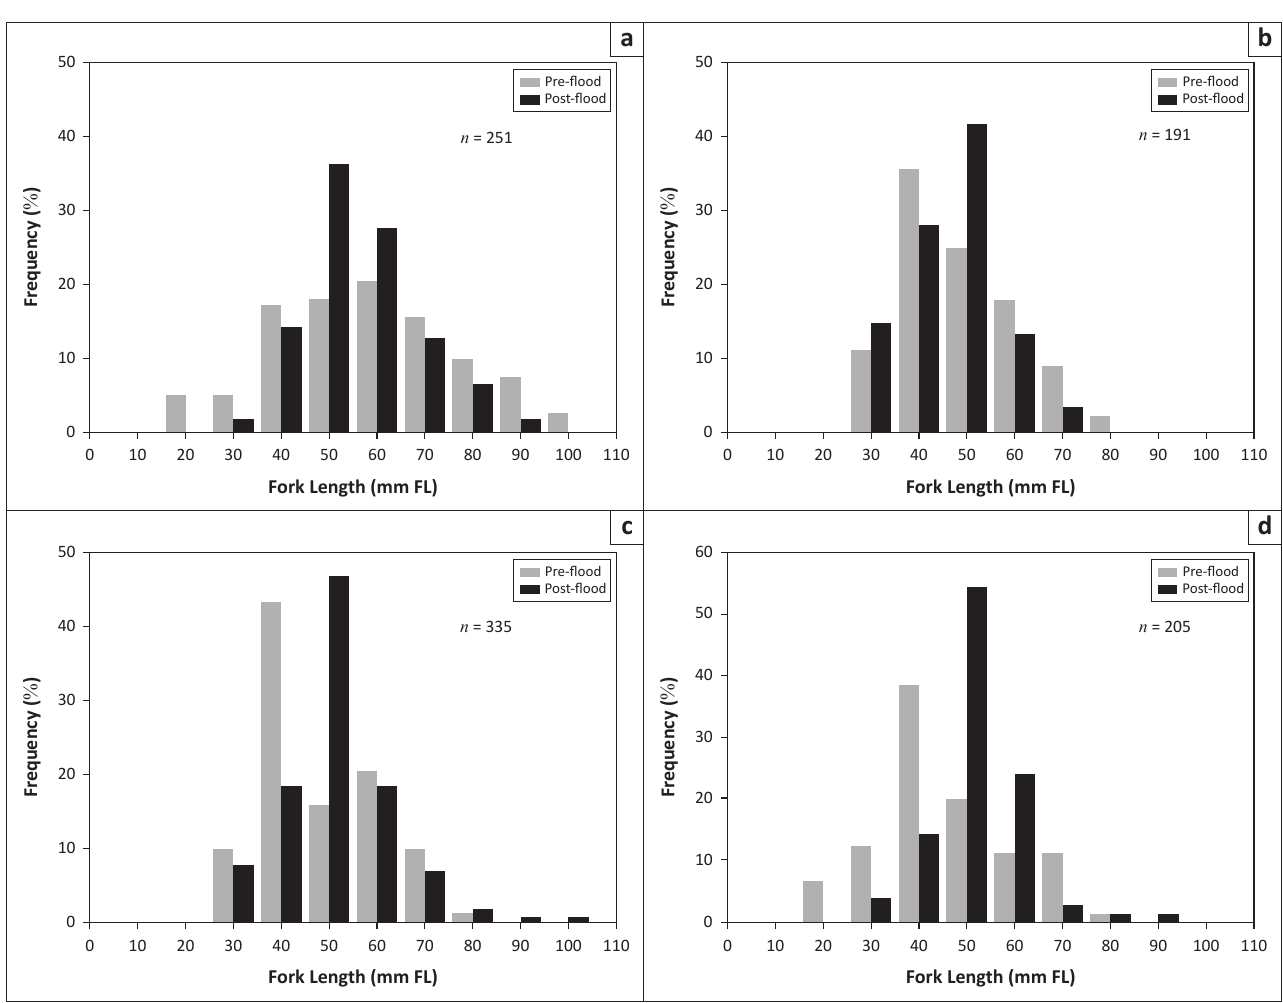
FIGURE 4: Pre-flood and post-flood length frequency distribution for Pseudobarbus afer from the upper and lower reaches of the Fernkloof (a = lower; c = upper) and Waterkloof (b = lower; c = upper) streams, headwater tributaries of the Kwa-Zunga River within the Groendal Wilderness Area, Eastern Cape, South